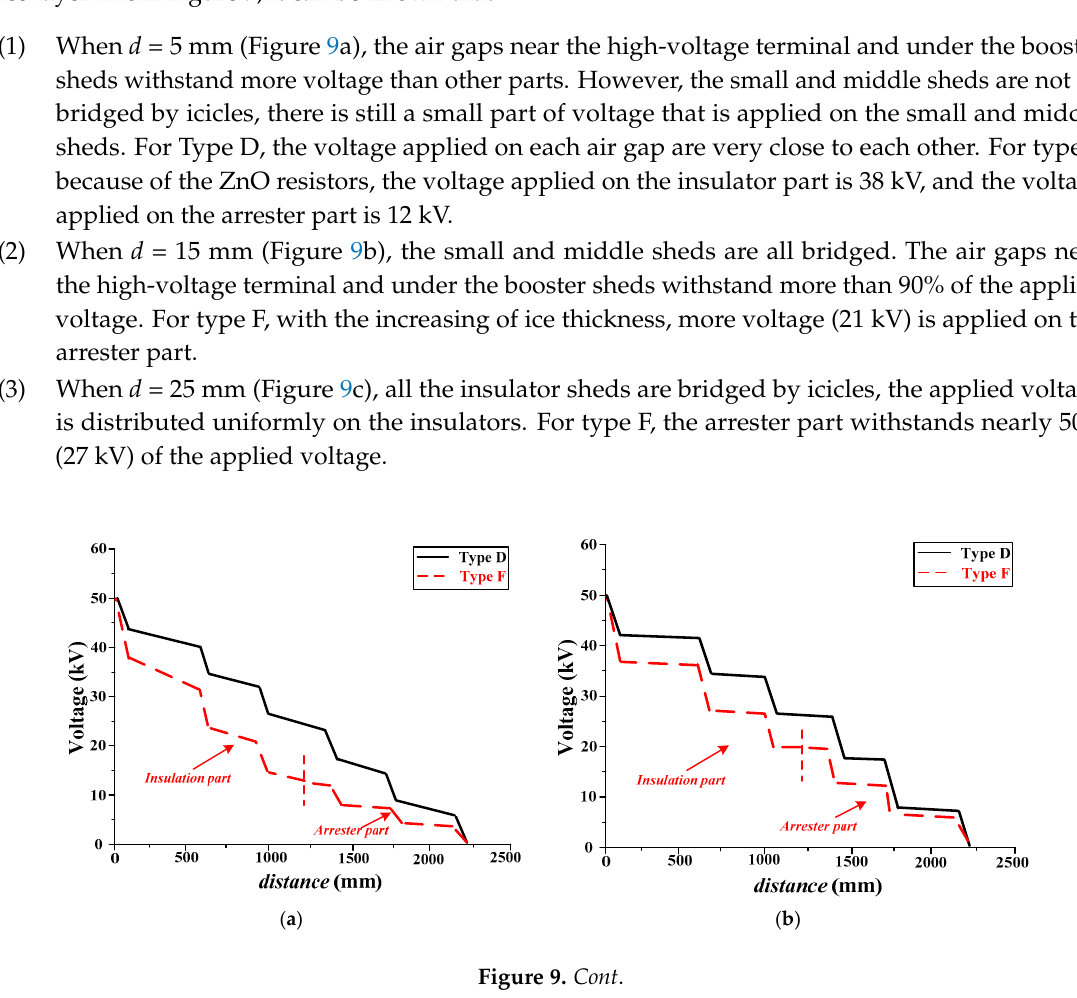
Figure 8. Most possible flashover path under different icing conditions. ( a ) d = 5 mm; ( b ) d = 15 mm; and ( c ) d = 25